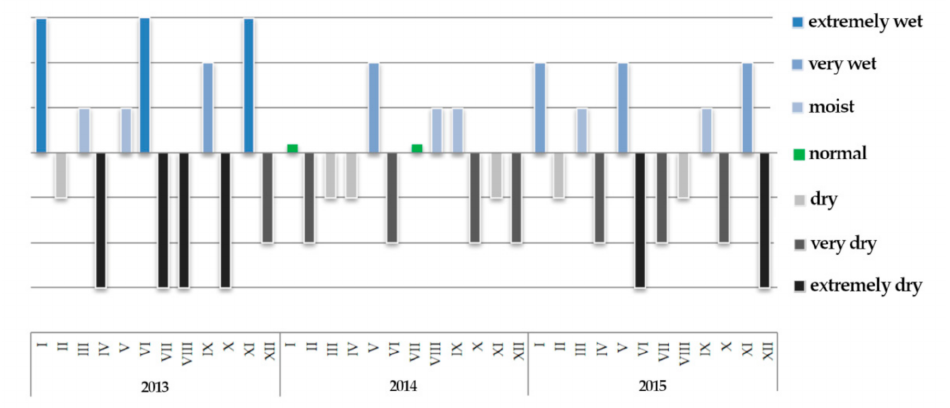
Figure 2. Classification of consecutive months in the years of study according to the monthly precipitation sum and precipitation norm from 1971 to 2000. Based on data from Bulletins of the Hydrological and Meteorological Service [30–32].